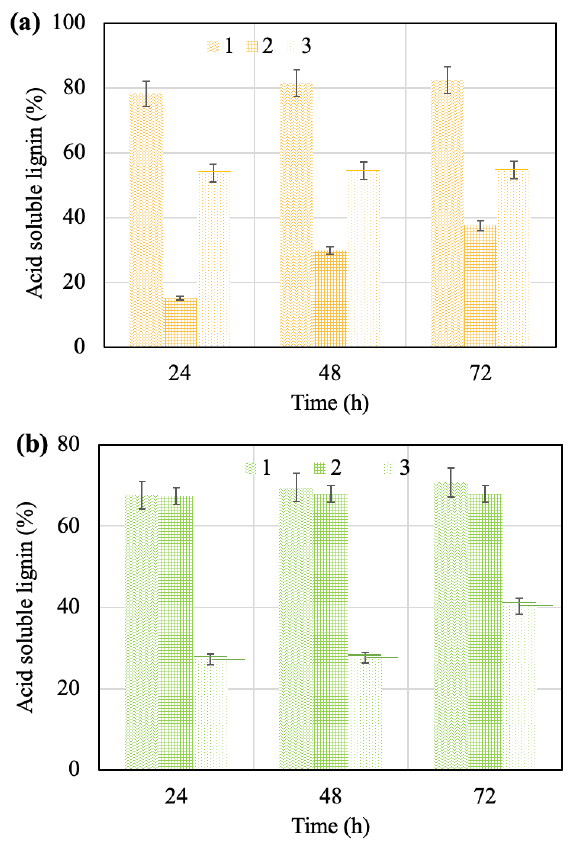
Figure 4. Effect of time of the process on amount of acid ‐ soluble lignin in solids after hydrolysis of materials based on apricot seed shells ( a ) and walnut shells ( b ): 1—solid after acid pretreatment; 2—solid after alkaline pretreatment; 3—solid after pretreatment with steam explosion.